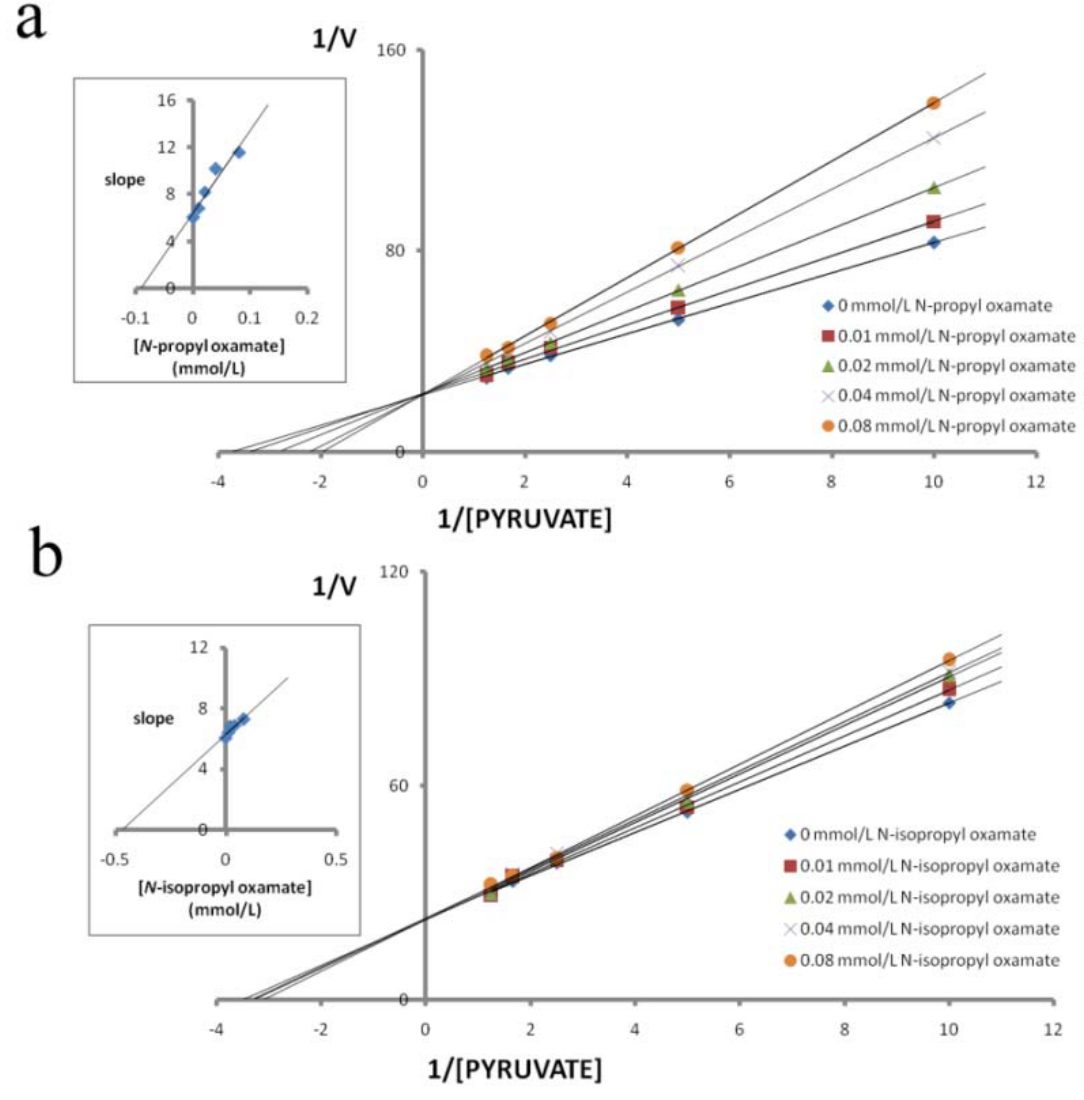
Figure 1. Effect of pyruvate on the inhibitory activity of N- propyloxamate and N- isopropyl oxamateon plateau pika LDH-A 4 . Reciprocal values of V were calculated taking the reciprocal values of △ 340 nm/min, plots of reciprocal reaction velocity versus reciprocal pyruvate concentration at a constant NADH concentration. The concentrations of pyruvate used were 0.1 mmol/L, 0.2 mmol/L, 0.4 mmol/L, 0.6 mmol/L and 0.8 mmol/L. NADH concentration was kept at 0.15 mmol/L. The Km of LDH-A 4 for pyruvate was 0.260 mmol/L. ( ◆ ) assays with 0 mmol/L, ( ■ ) 0.01 mmol/L, ( ▲ ) 0.02 mmol/L, (×) 0.04 mmol/L and ( ● ) 0.08 mmol/L of N- propyl oxamate or N- isopropyl oxamate. Upper left: determination of Ki from replot of slope values against inhibitor concentrations. The Ki of N- propyl oxamate and N- isopropyl oxamate for LDH-A 4 were 0.094 mmol/L and 0.462 mmol/L,